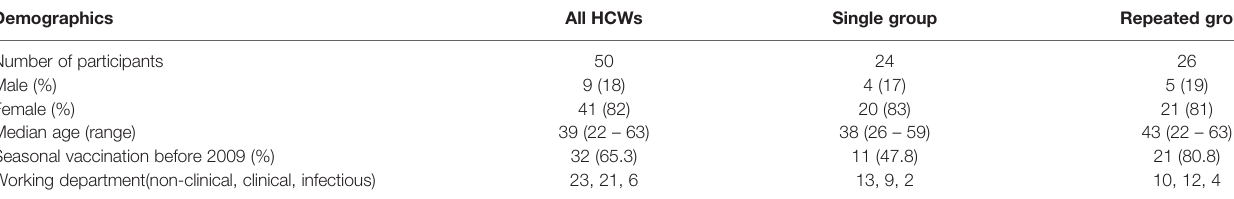
TABLE 1 | Demographics of the study